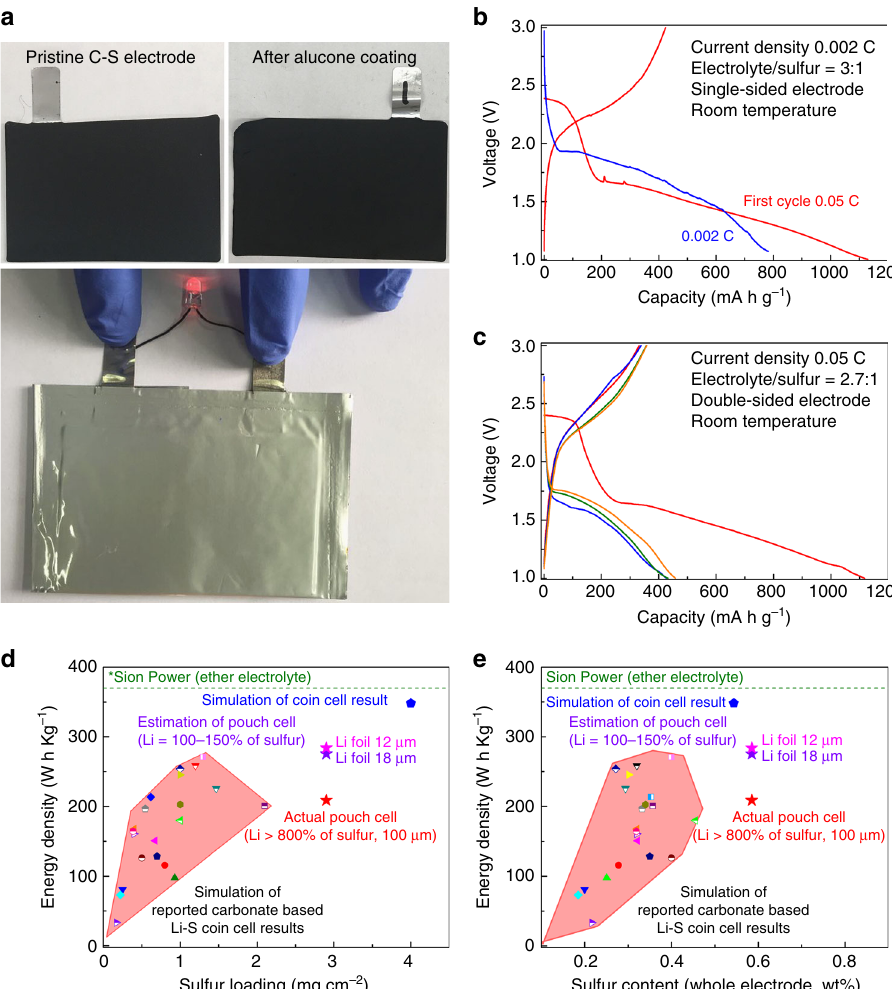
Fig. 5 Pouch cell test of lithium – sulfur batteries in carbonate-based electrolyte. a As-prepared C – S electrodes (before and after alucone coating) and an assembled pouch cell. b , c Discharge – charge pro fi les of assembled pouch cells under different test conditions. d , e Measured and simulated energy density of our work and reported lithium – sulfur coin cells in carbonate electrolyte. The reported energy density of Sion Power lithium – sulfur pouch cell in ether- based electrolyte is labeled as a reference